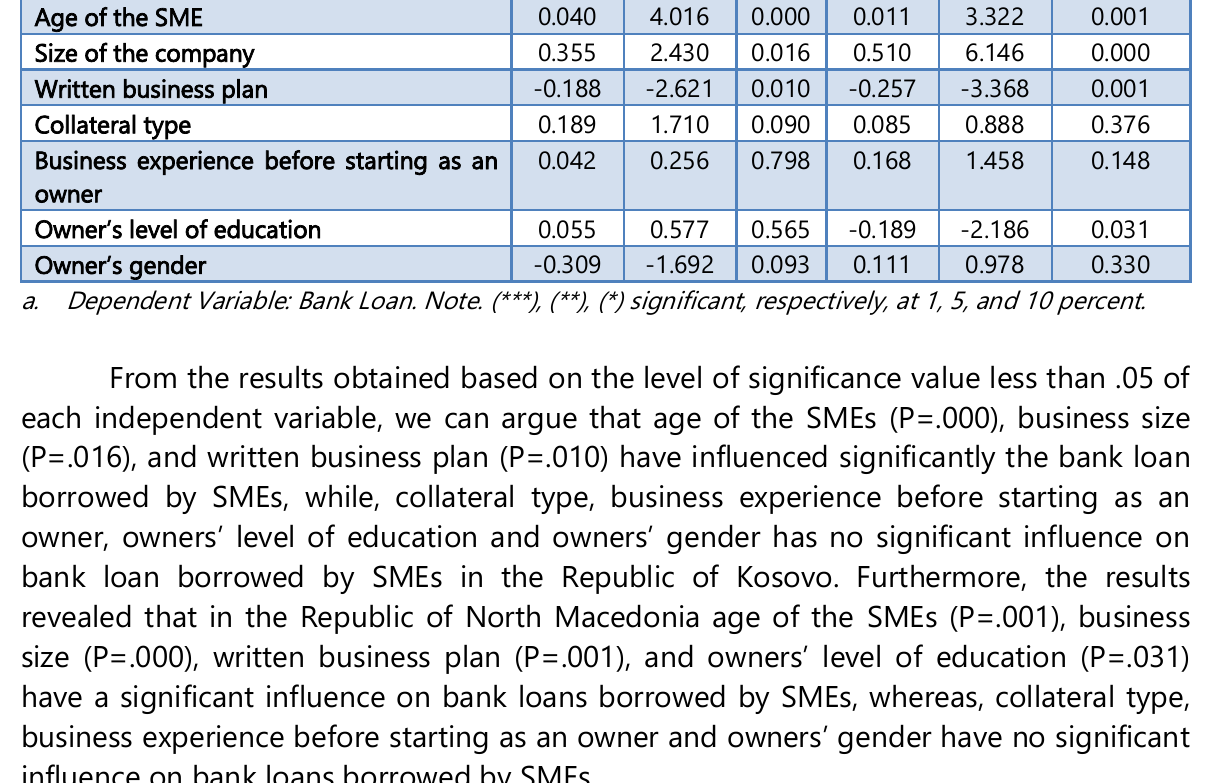
Table 4: Multiple Linear Regression Analysis (Source: Authors‟ depiction) Kosovo North Macedonia B t Sig. B t Sig. Constant 1.618 3.615 0.000 1.733 5.415 0.000 0.040 -0.188